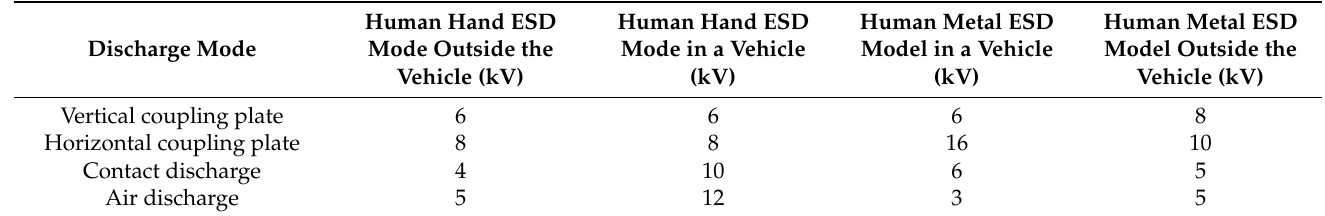
Table 3. Fault threshold of the unmanned vehicle handling system caused by different discharge modes and discharge models.